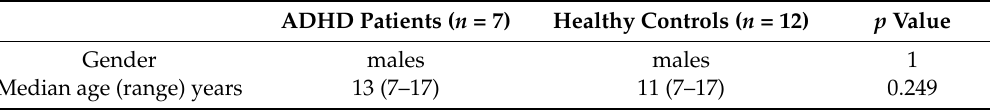
Table 1. Demographic information of individuals included in the